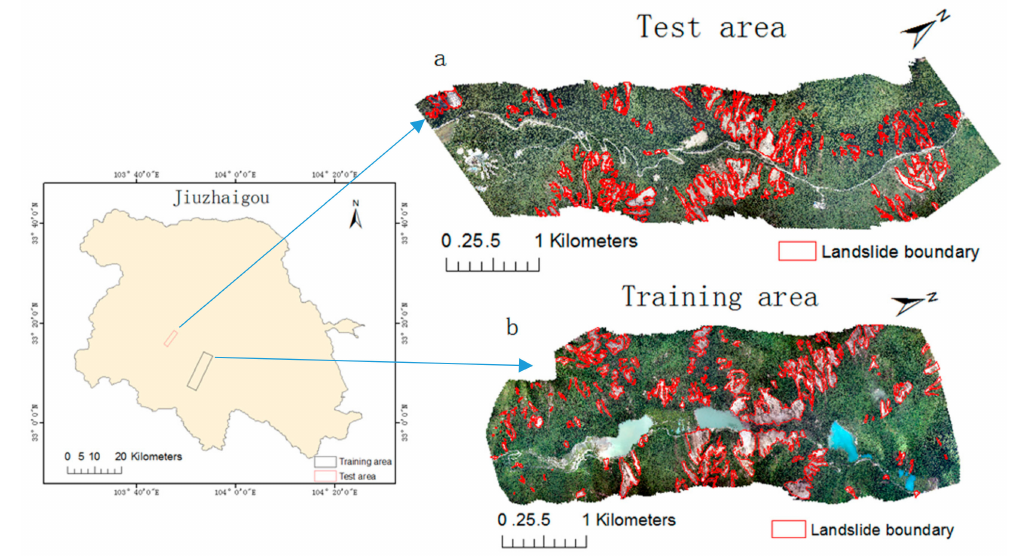
Figure 6. Test ( a ) and training ( b ) area